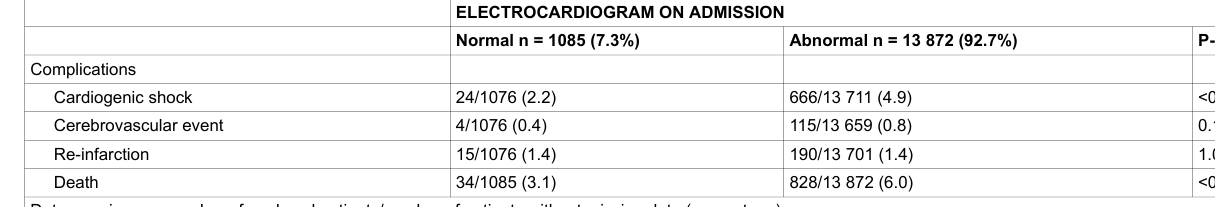
Table 3 Early outcome according to the patient’s ECG on admission.